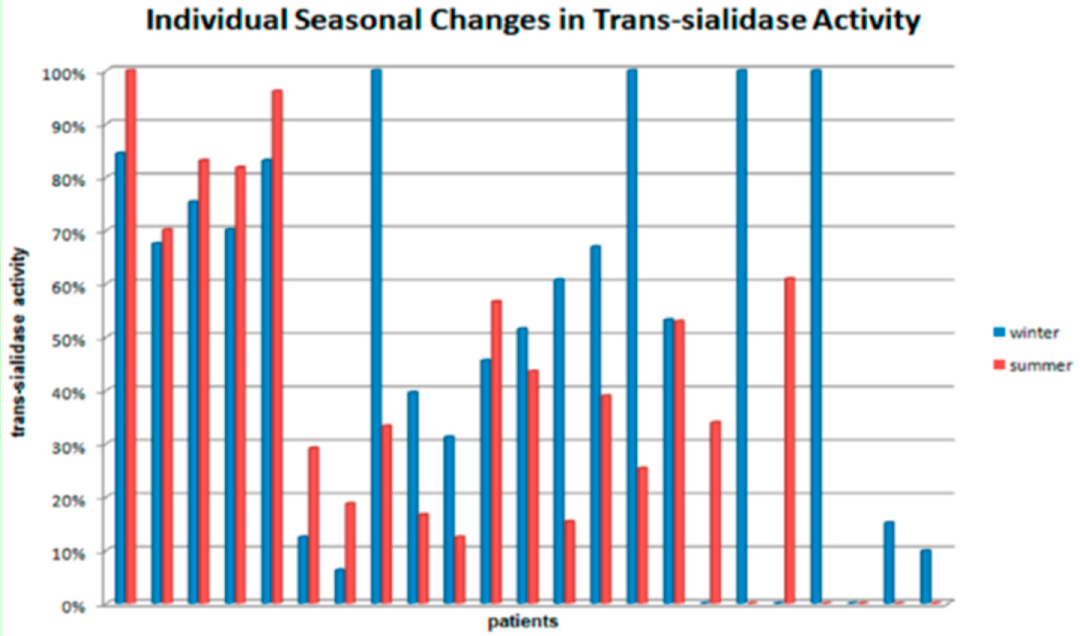
Figure 1. Seasonal dynamics of sialidase activity in blood serum of study participants.